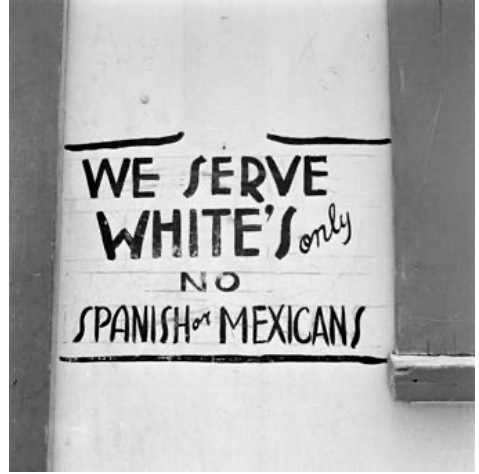
Figure 5. Segregation Signage (Lee n.d.).